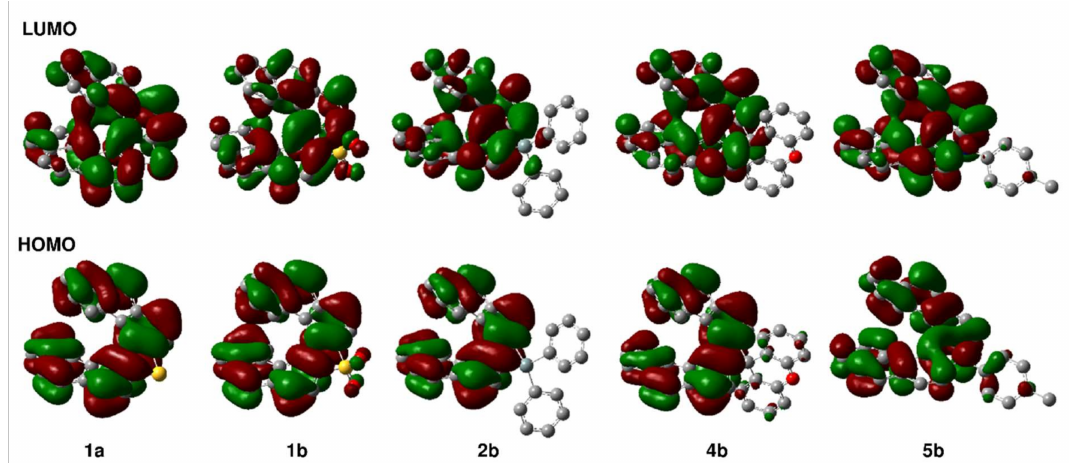
Figure 3. Frontier molecular orbitals of 1a , 1b , 2b , 4b , and 5b calculated by DFT method at the B3LYP/6-31G(d) level of